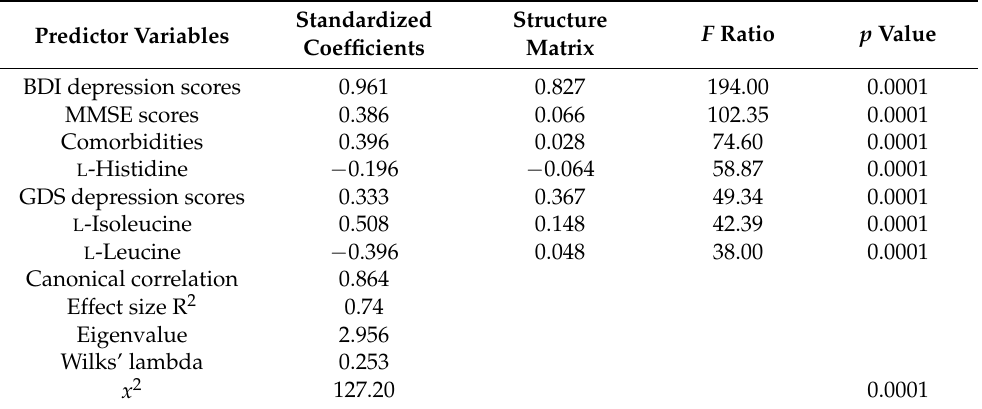
Table 3. Outcomes of standardized canonical discriminant function coefficients and predictor vari- ables ordered by absolute size of correlation within function.